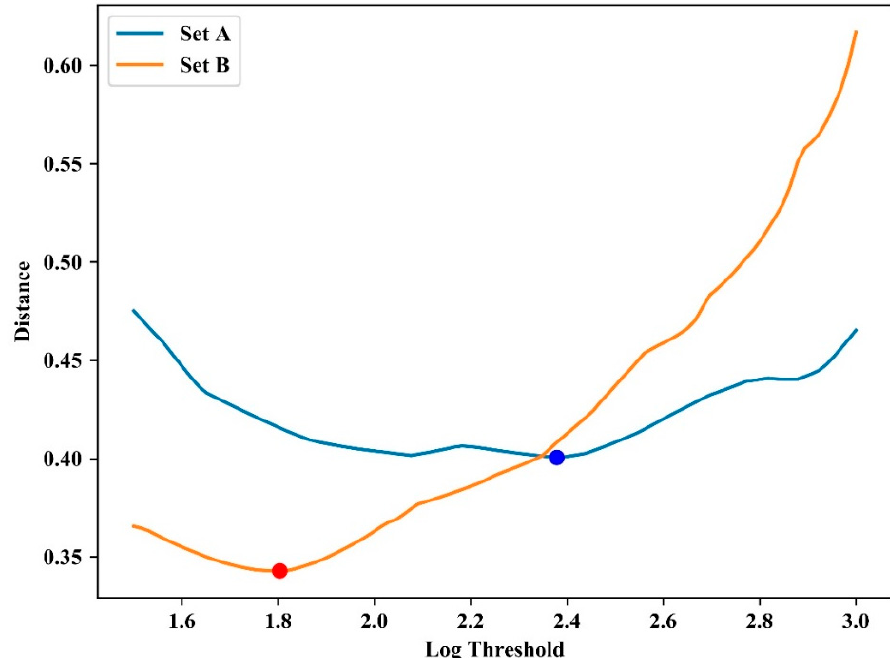
Figure 9. Distance distribution according to log threshold for each experiment set.